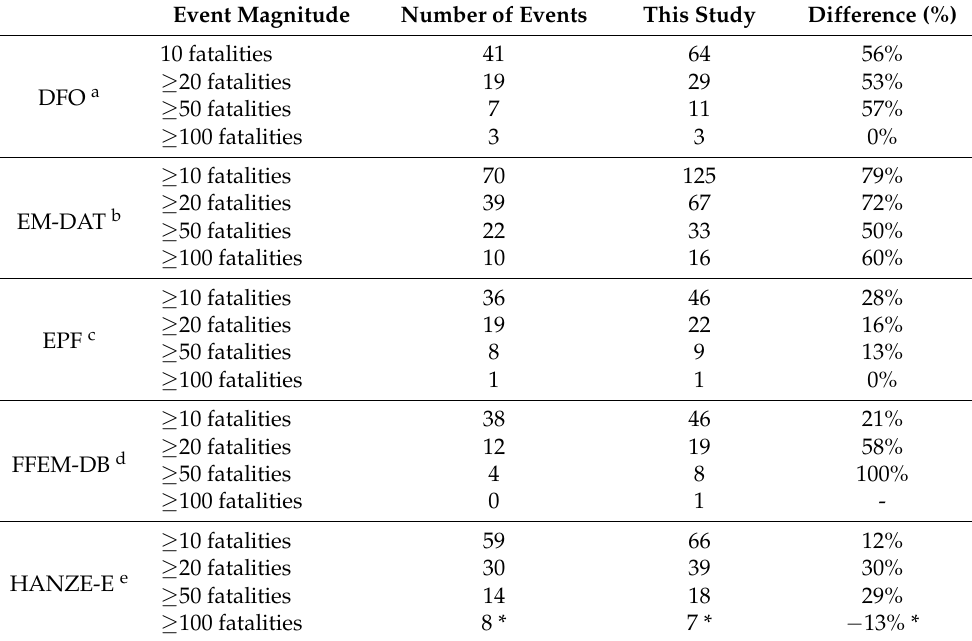
Table 2. Comparison of the number of flash flood events per event magnitude of the current study against other international databases. It should be mentioned that the thresholds of event magnitudes were selected arbitrarily for illustrative purposes. Only flash flood events and flash flood-related fatalities are considered. Other flood types are excluded.